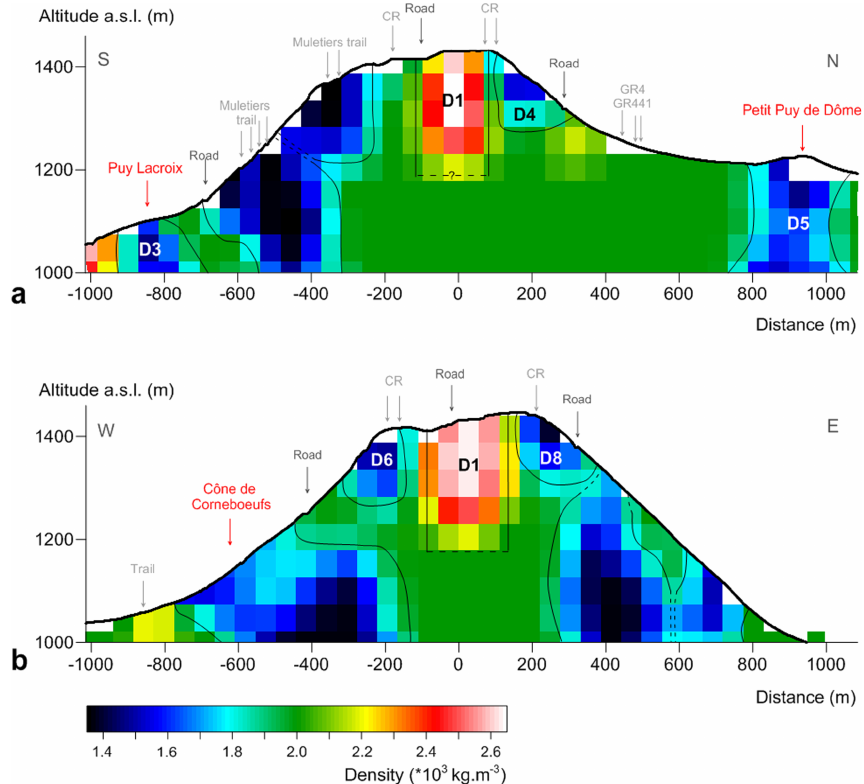
Fig. 4. Sections in the 3-D density models of the Puy de Dˆome